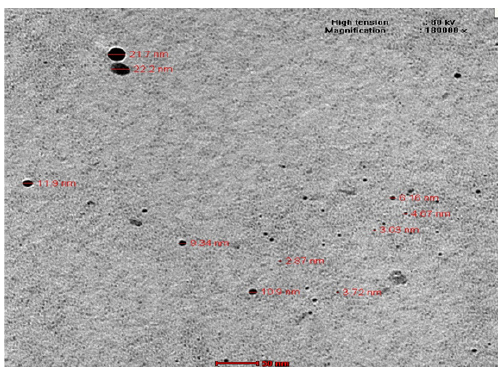
Fig. 6. X-ray microanalysis of silver nanoparticles Fig. 5. TEM of silver nanoparticles synthesized by synthesized by Pseudomonas sp . H64 Pseudomonas sp . H64 table 1. Antibacterial activity of AgNPs (expressed as inhibition zone diameter (mm) against different Gram positive and Gram negative bacterial pathogens Bacterial